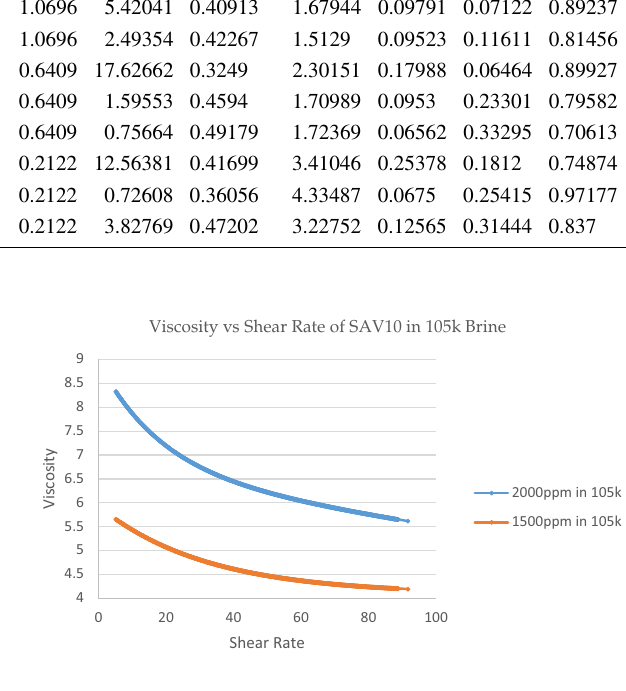
Fig. 14 Effect of SAV10 concentration on